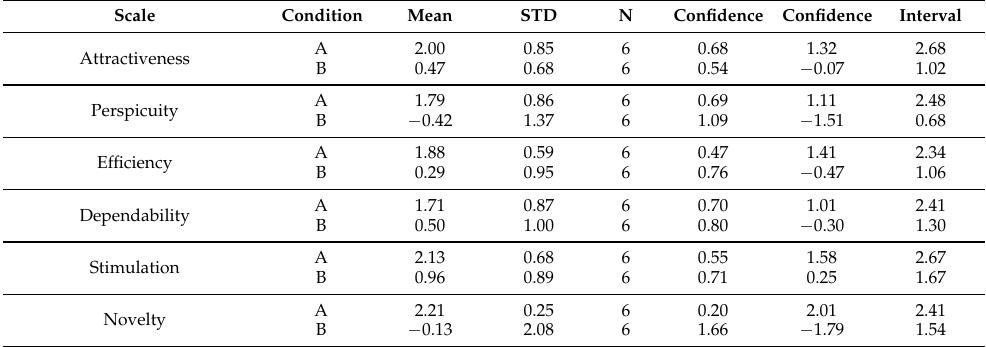
Table 4. Individual product assessment result of all six study participants in two conditions: with MR guidance (A) and Without MR guidance